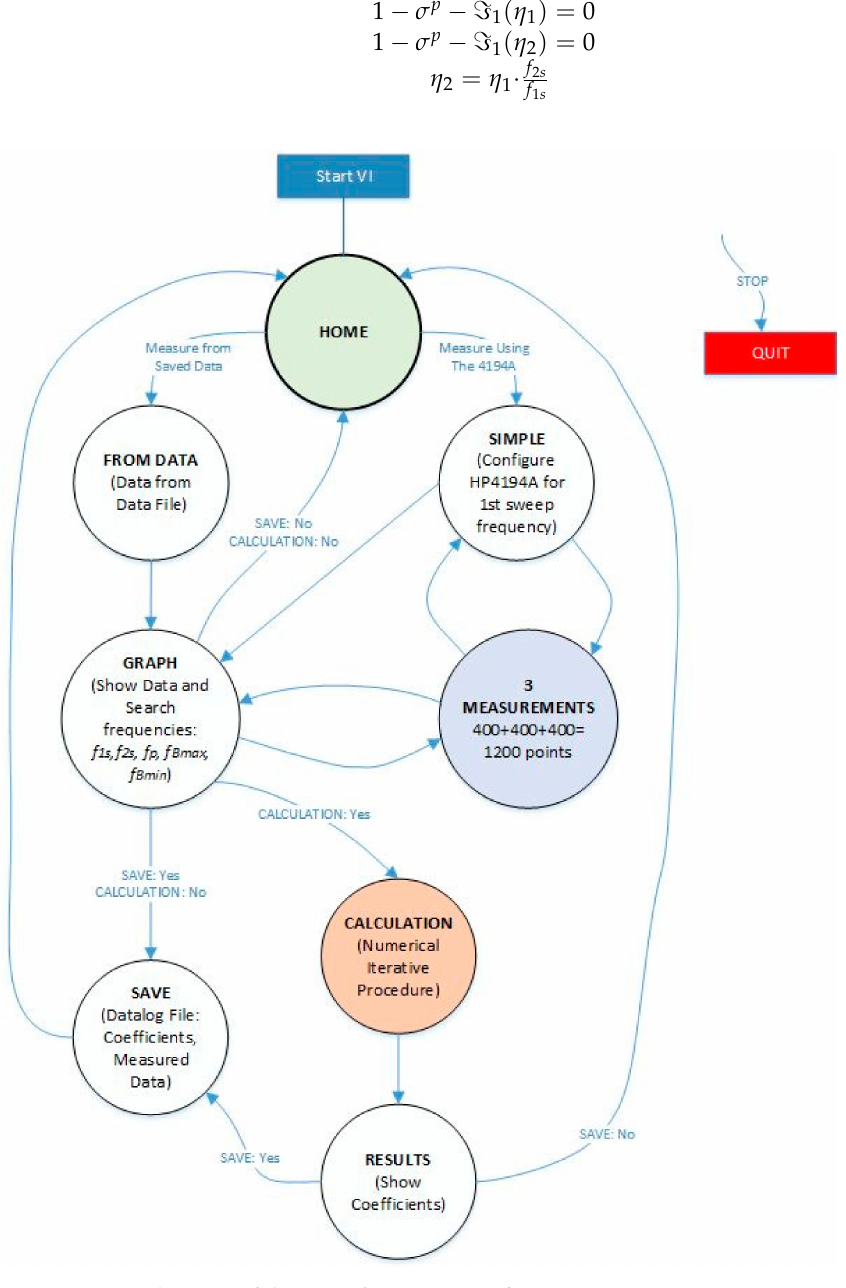
Figure 7. State diagram of the Virtual Instrument